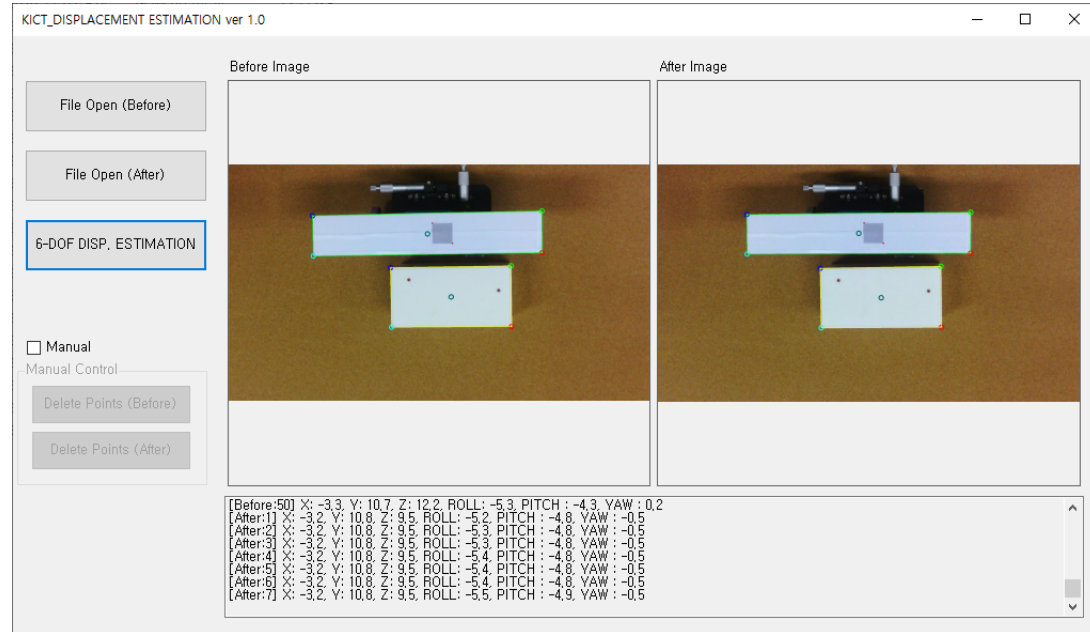
Figure 7. Graphic User Interface for estimating 6-DOF displacement.